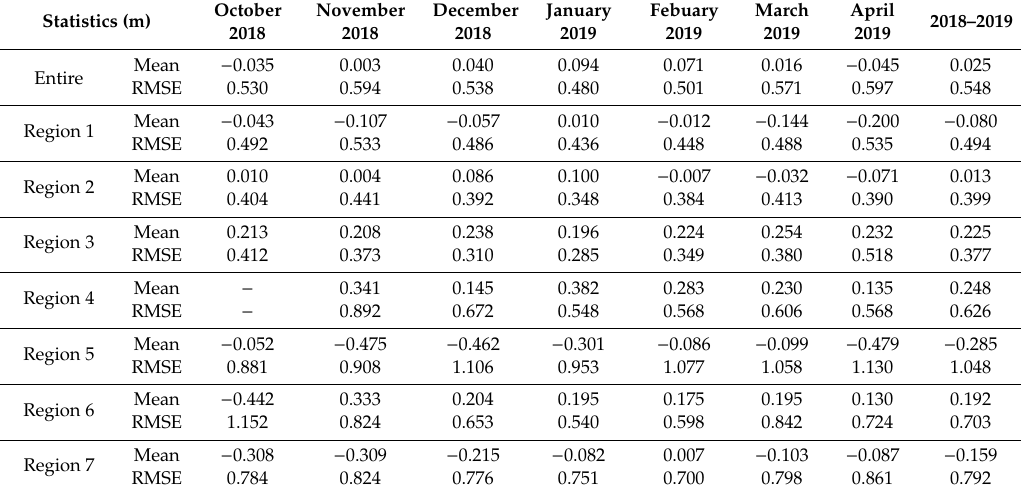
Figure 7. Annual average thickness variations of the Arctic sea ice from 2010 / 2011 to 2018 / 2019 estimated using the LSA method. The blue dots indicate total ice thickness, the green dots indicate first-year ice thickness, and the red dots indicate multiyear ice thickness. Table 3. Statistics of the sea ice thickness bias between the LSA and Alfred Wegener Institute (AWI). Statistics (m)